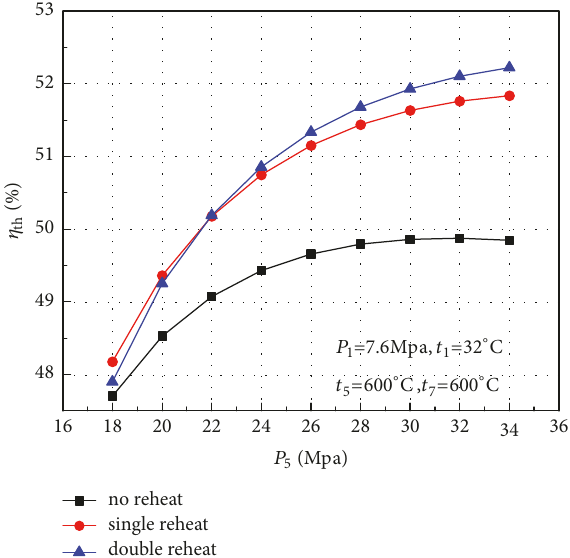
Figure 10: Effects of LPT inlet pressure on cycle efficiency at different LPT inlet